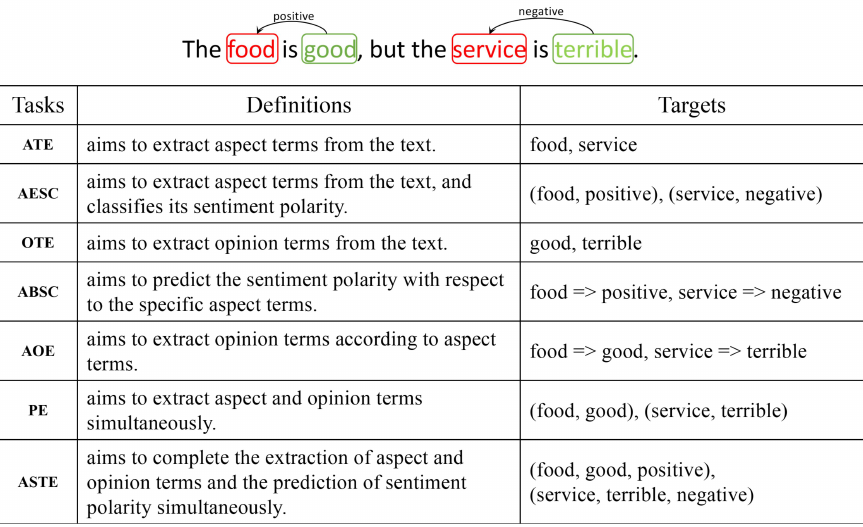
Figure 1. Example of the task categories in (ABSA) Aspect-Based Sentiment